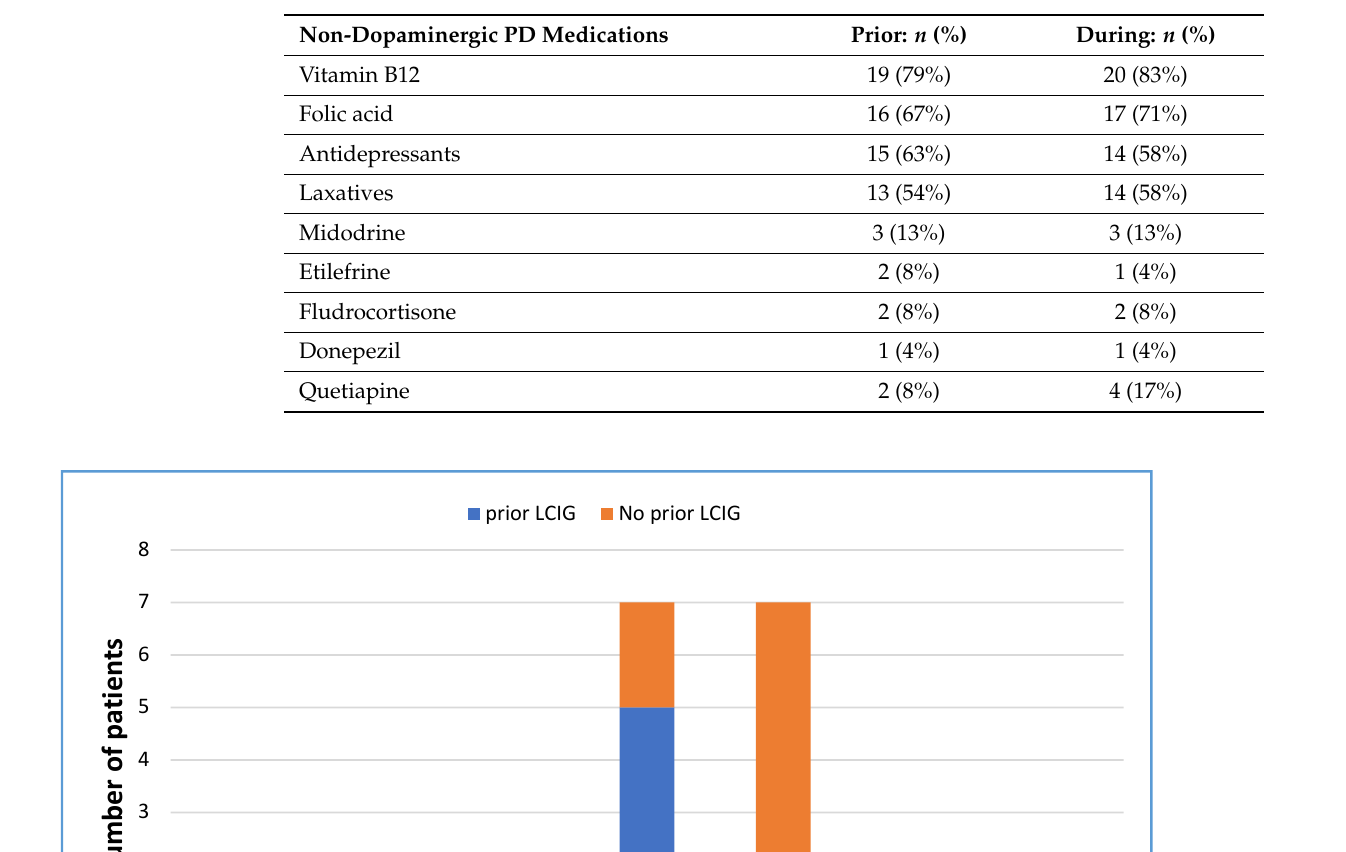
Table 6. Non-dopaminergic PD treatment prior to and during LECIG ( n = 24).